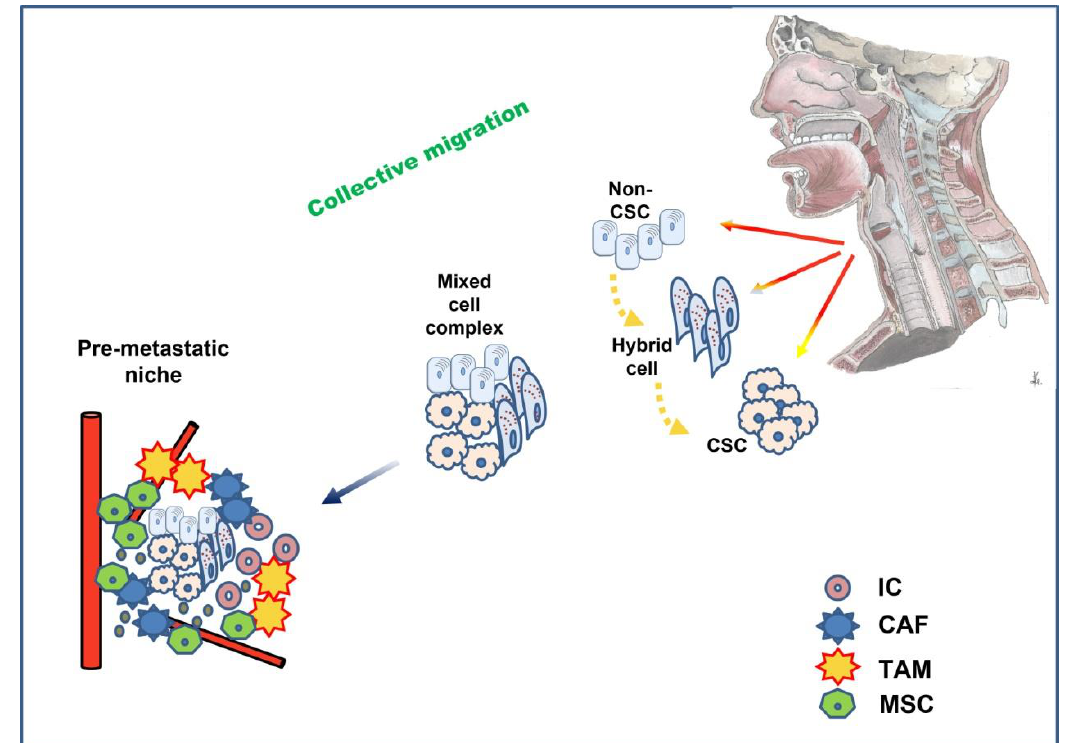
Figure 3. Partial (hybrid) EMT plays a key role in collective migration: clusters of mixed cancer cells in different stages of EMT and stemness invade and travel through the circulation to the premetastatic niche, where interaction with a variety of cells promotes MET and eventually successful seeding at the distant site. CSC: cancer stem cell; IC: immune cell; TAM: tumor-associated macrophages; CAF: cancer-associated fibroblast; MSC: mesenchymal stem cell.